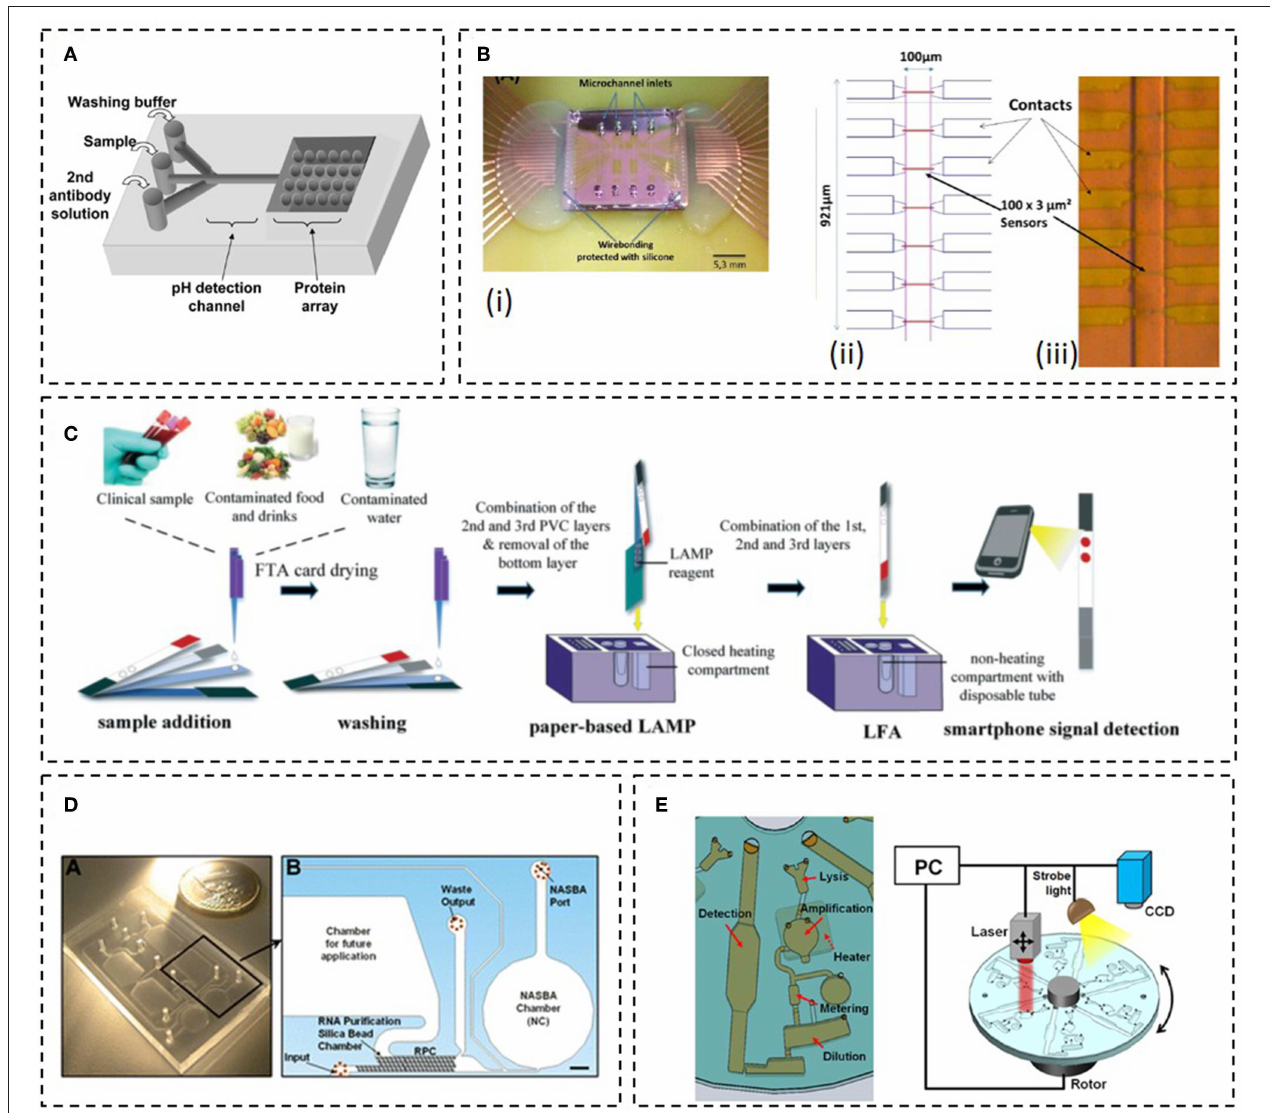
FIGURE 4 | Examples of LoC systems for the detection of bacteria. (A) Schematics of the device proposed by Choi et al. Adapted from Choi et al. (2006); (B) Final device proposed by Duarte et al. with the MR chip bonded to the polydimethylsiloxane (PDMS) microchannels (i); Sensor layout showing the distribution of the Spin-valve sensors along the microchannels (ii) and a photograph showing a representative microchannel aligned over the sensors (iii). Adapted from Duarte et al. (2016); (C) 3D paper-based microfluidic proposed by Choi et al. Reprinted with permission from Choi et al. (2016). Copyright 2016 Royal Society of Chemistry; (D) Monolithic device proposed by Dimov et al. (inset A ) and schematics showing the different unitary operations occurring inside the device (inset B ). Adapted with permission from Dimov et al. (2008). Copyright 2008 Royal Society of Chemistry; (E) Scheme of the LoC device proposed by Kim et al. Adapted with permission from Kim et al. (2014). Copyright 2014 American Chemical